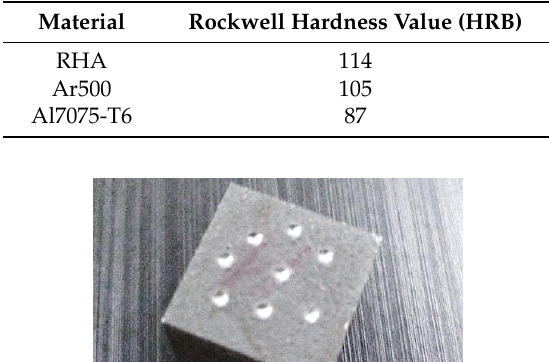
Table 4. Summary of average hardness for each material.